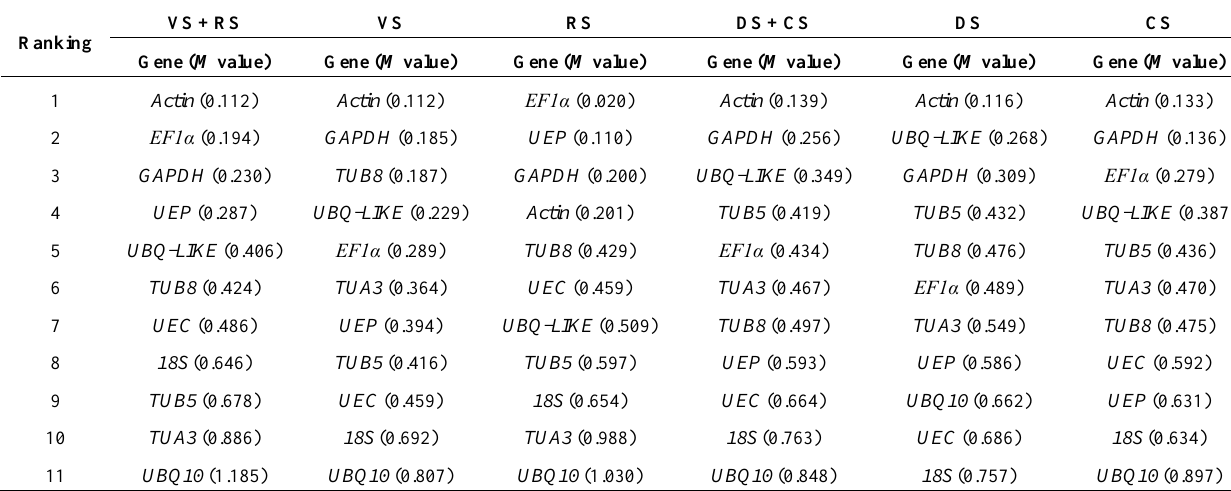
Table 2. Candidate reference genes ranked according to their expression stability ( M value) as determined by